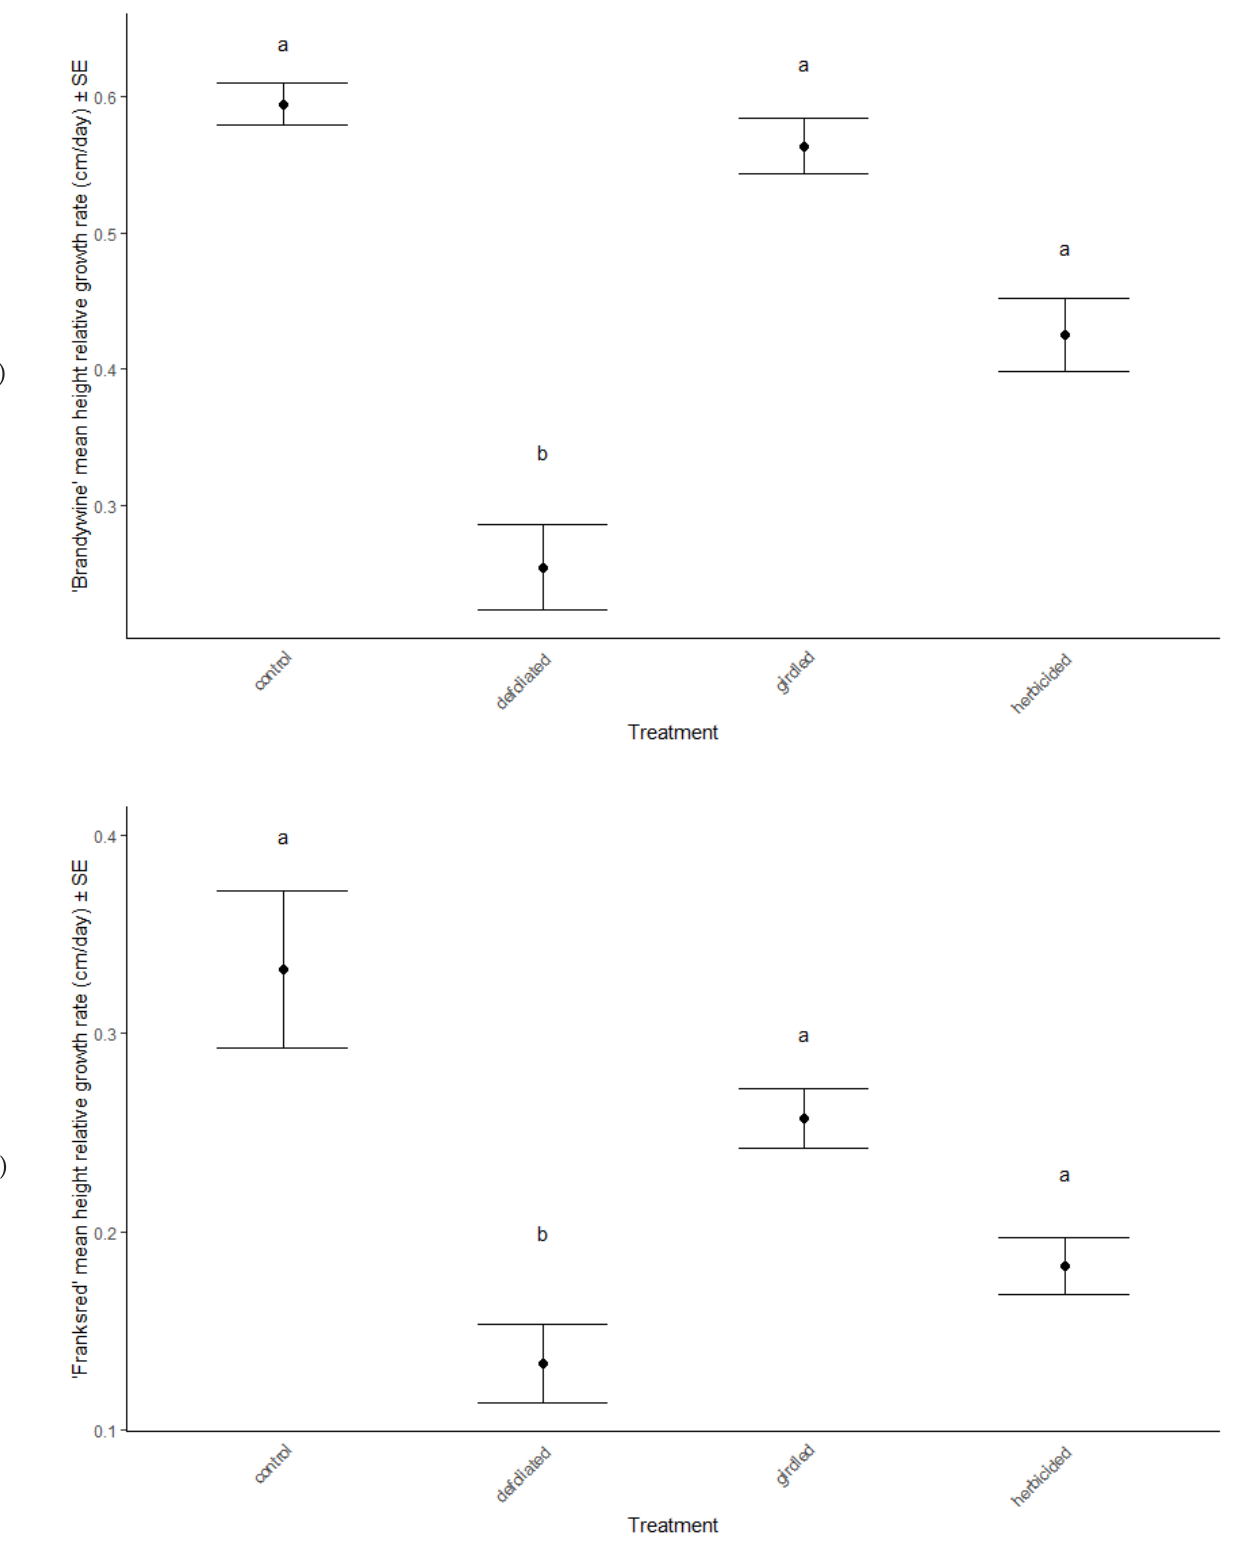
Figure 2. Relative growth rate (RGR in cm/day) of red maple ( Acer rubrum) cultivars ( a ) ‘Brandywine’ and ( b ) ‘Franksred’ in response to stress treatments. Different letters represent statistical differences between treatments according to a post hoc Tukey HSD analysis ( p < 0.05).